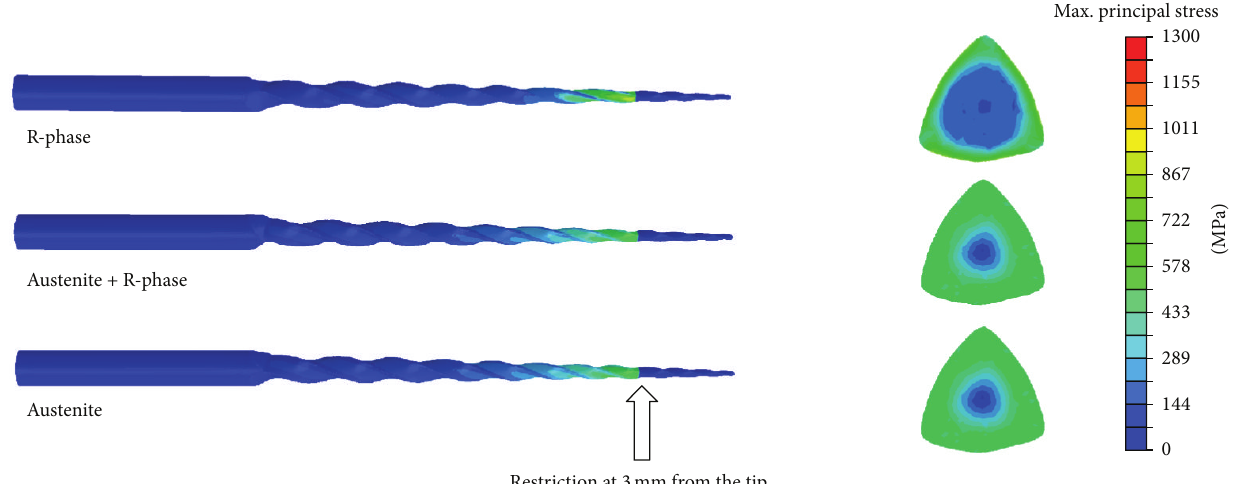
Figure 11: Maximum principal stress distributions in the endodontic instruments subjected to